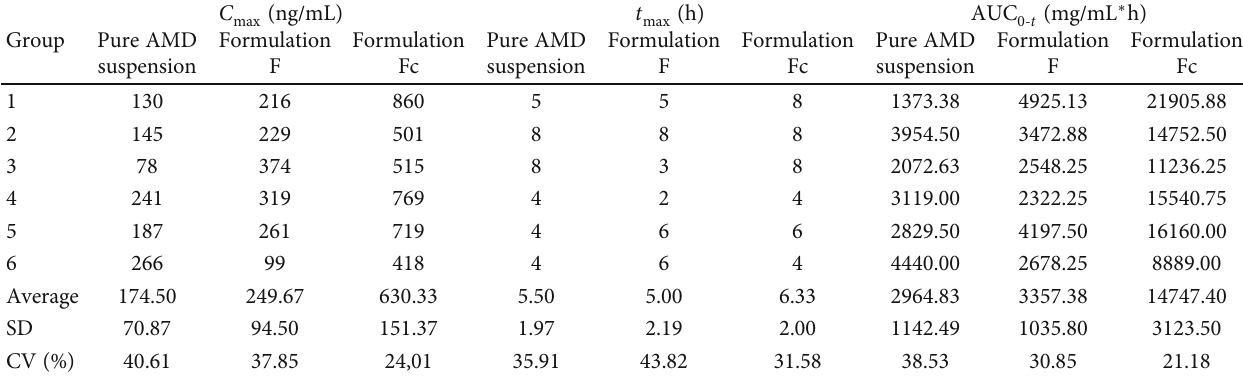
Figure 15: Plasma AMD concentration versus time pro fi les in Wistar rats following oral administration of formulation Fc, formulation F, and pure AMD suspension ( mean ± SD , n = 6 ). Table 9: C , t , and AUC of pure AMD suspension and F10 and F1 formulations in Wistar rats following single oral administration max max 0 ‐ t ( mean ± SD , n = 6